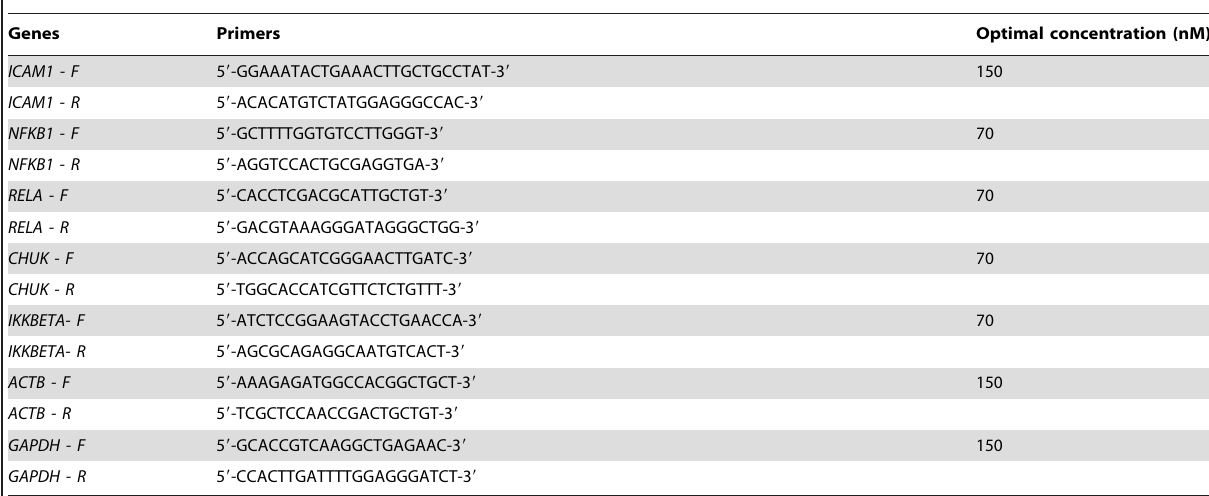
Table 2. Primer sequences for performance of real-time quantitative